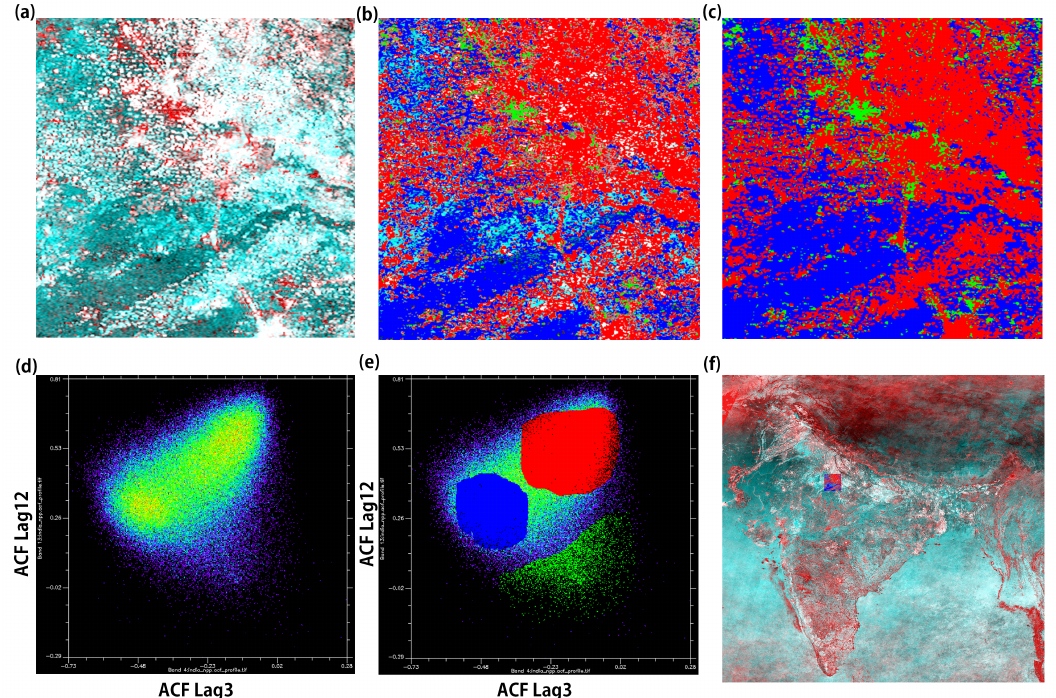
Figure 16. Classification of ACF into different cycling patterns. ( a ) Training area showing the RGB composite of ACF Lag3 as red and Lag12 as blue and green. ( b ) Training samples selected for different categories. The red cluster is the single peak, green acyclic, and blue the double peak. ( c ) Classification result with Mahalanobis distance classification. ( d ) Scatter plot of the RGB composite. ( e ) Samples selected in scatter plot for training. The red cluster is the single peak, green acyclic, and blue the double peak. ( f ) The location of the training site as shown in the overall study